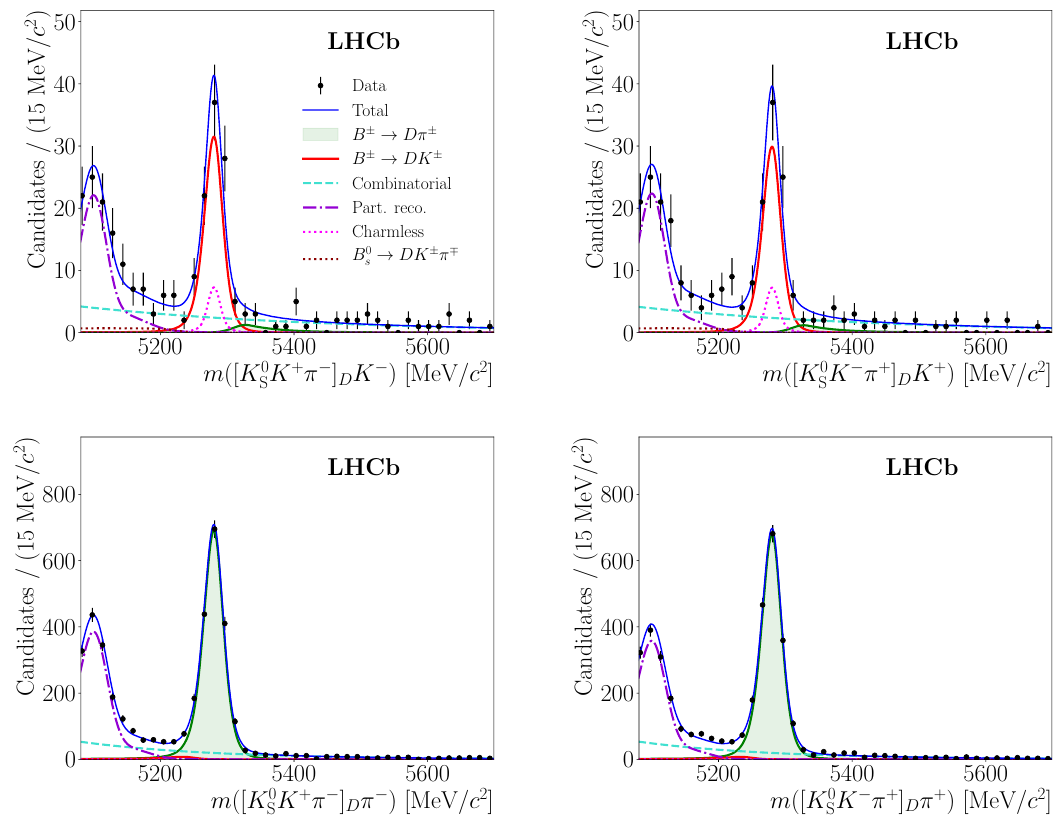
[ K 0 K (cid:7) (cid:25) (cid:6) ] D h (cid:6) candidates within the K (cid:3) + region. The (cid:12)t S !